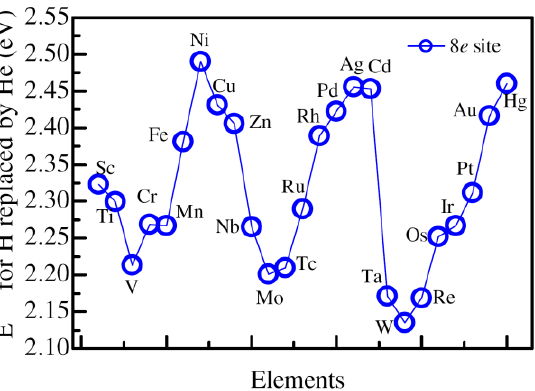
Figure 5. The substitution energy of He replacing H at the 8 e site closest to the Zr atom, which is substituted by various alloying elements.